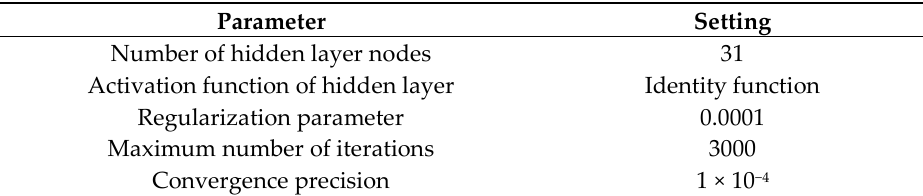
Table 3. Parameter settings of the Adam optimization BP neural network algorithm used for the first-stage LFD model.